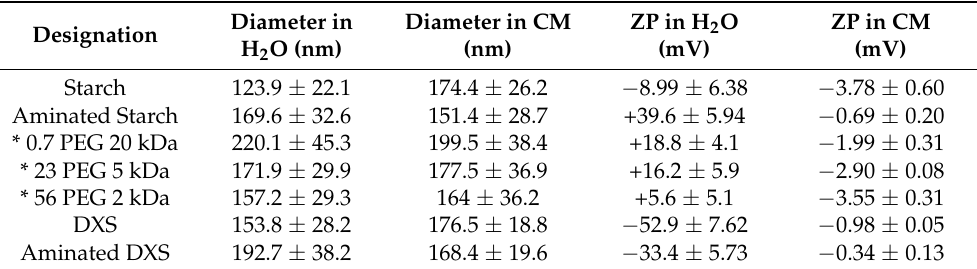
Table 1. Physical properties of the seven nanoparticle surface chemistries. The diameters and zeta potentials of each bead type were determined by dynamic light scattering. CM = complete cell culture medium (including serum and